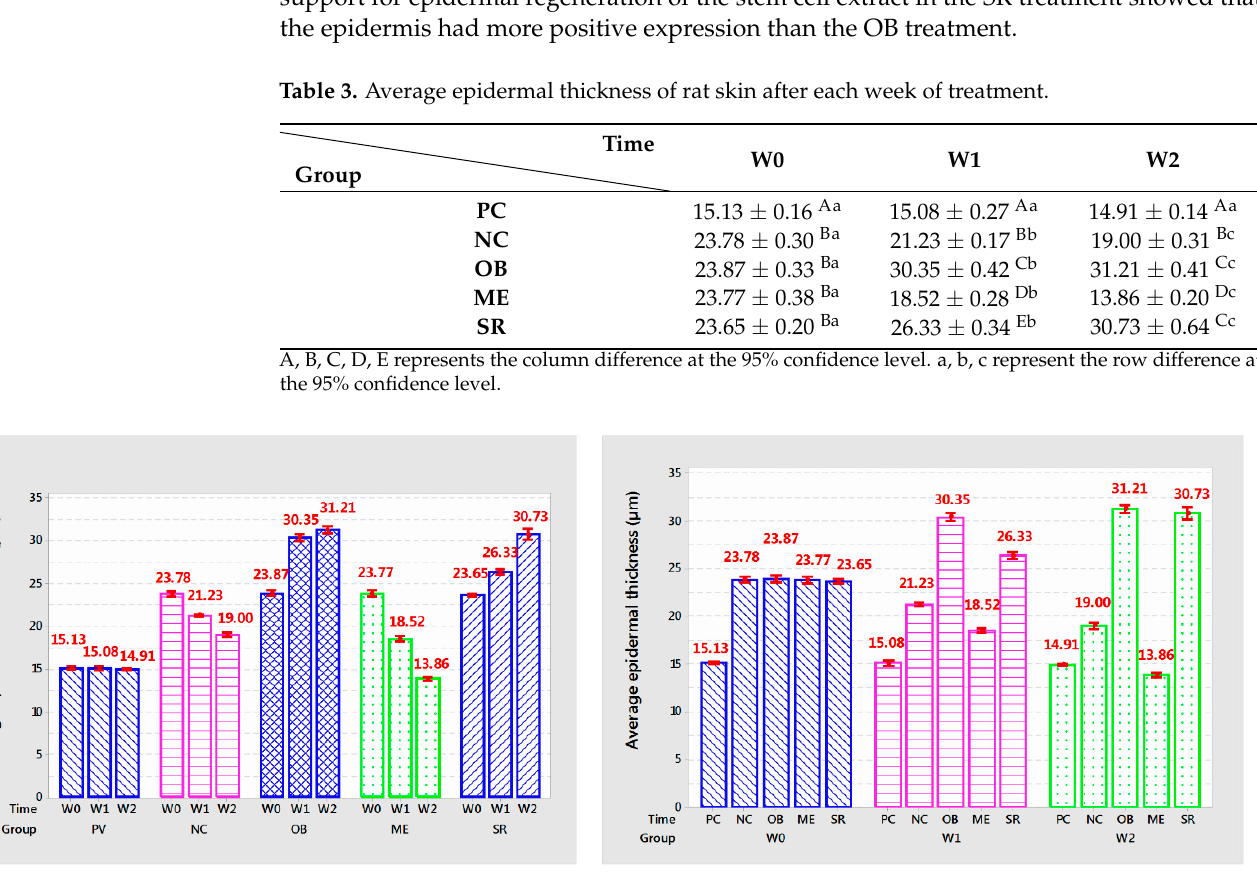
Table 3. Average epidermal thickness of rat skin after each week of treatment.